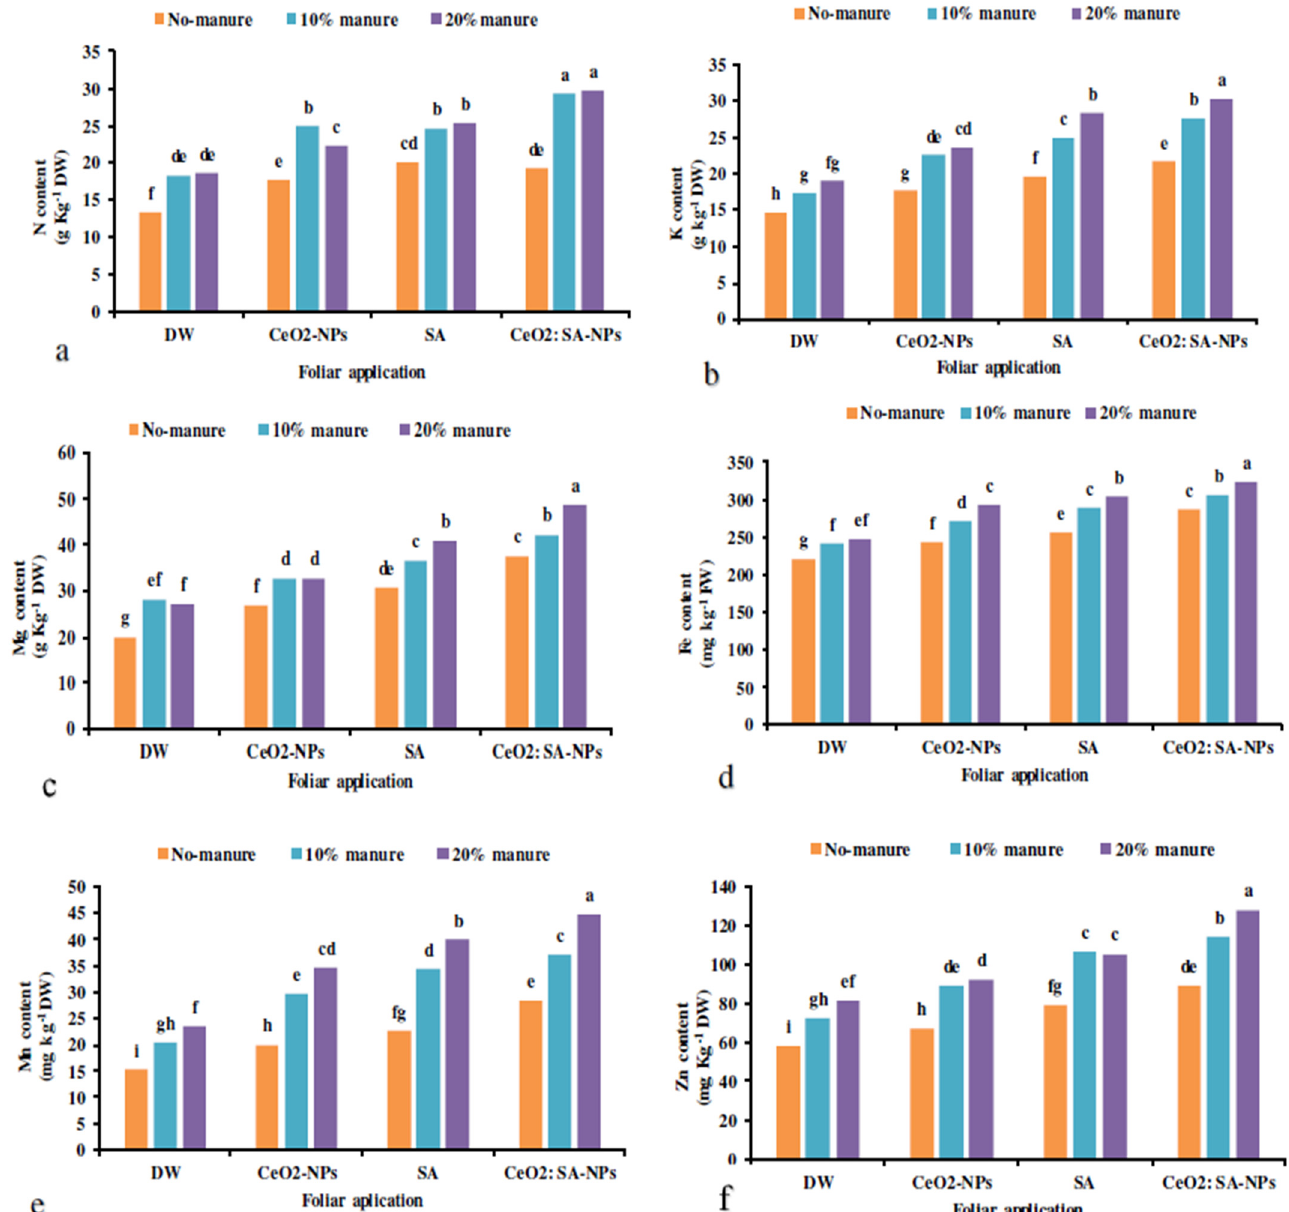
Figure 5. The interaction effects of soil-based animal manure application (0%, 10%, and 20% v / v ) and foliar spray of distilled water (DW), salicylic acid (SA), cerium oxide nanoparticles (CeO 2 -nanoparticles), and cerium oxide salicylic acid nanoparticles (CeO 2 : SA-nanoparticles) on the elemental content of Aloe vera plants ( a – f ). Significant differences among treatments are indicated by the different Latin letters.